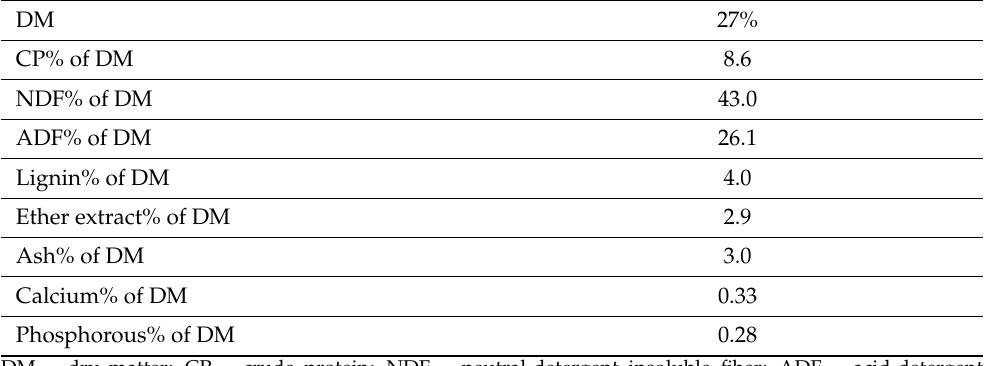
Table 2. Chemical composition of ingredients corn